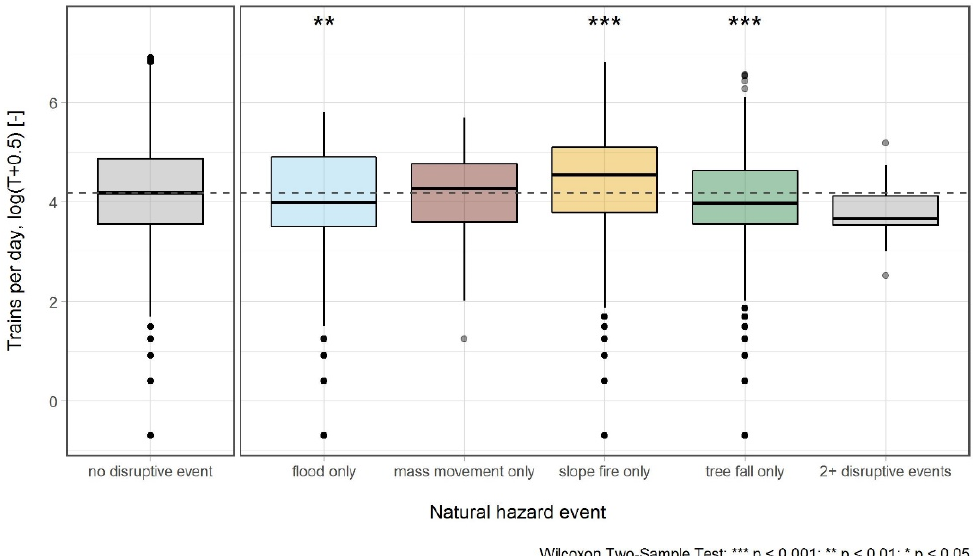
Figure 4. Box plots of train-count distributions by natural hazard event compared to the distribution of days with no disruptive event (leftmost plot). Asterisks indicate the level of statistical significance of the Wilcoxon two-sample test between the natural hazard event and no disruptive event. Data are based on the continuity-corrected log-transformation of trains per day, as shown in Figure